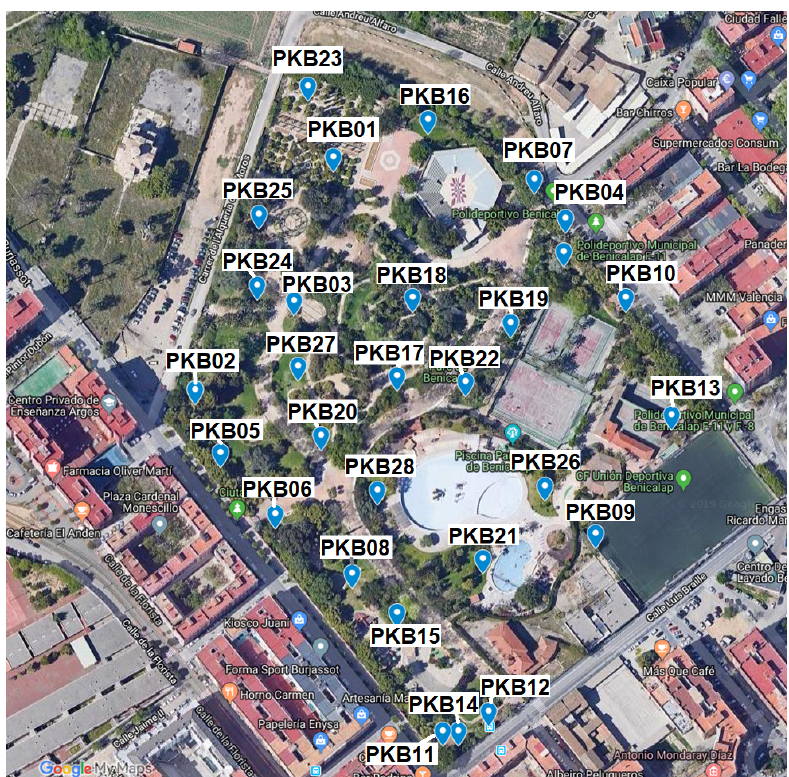
Figure 1. Park in Benicalap. Geolocation of sampling points (Google Maps).